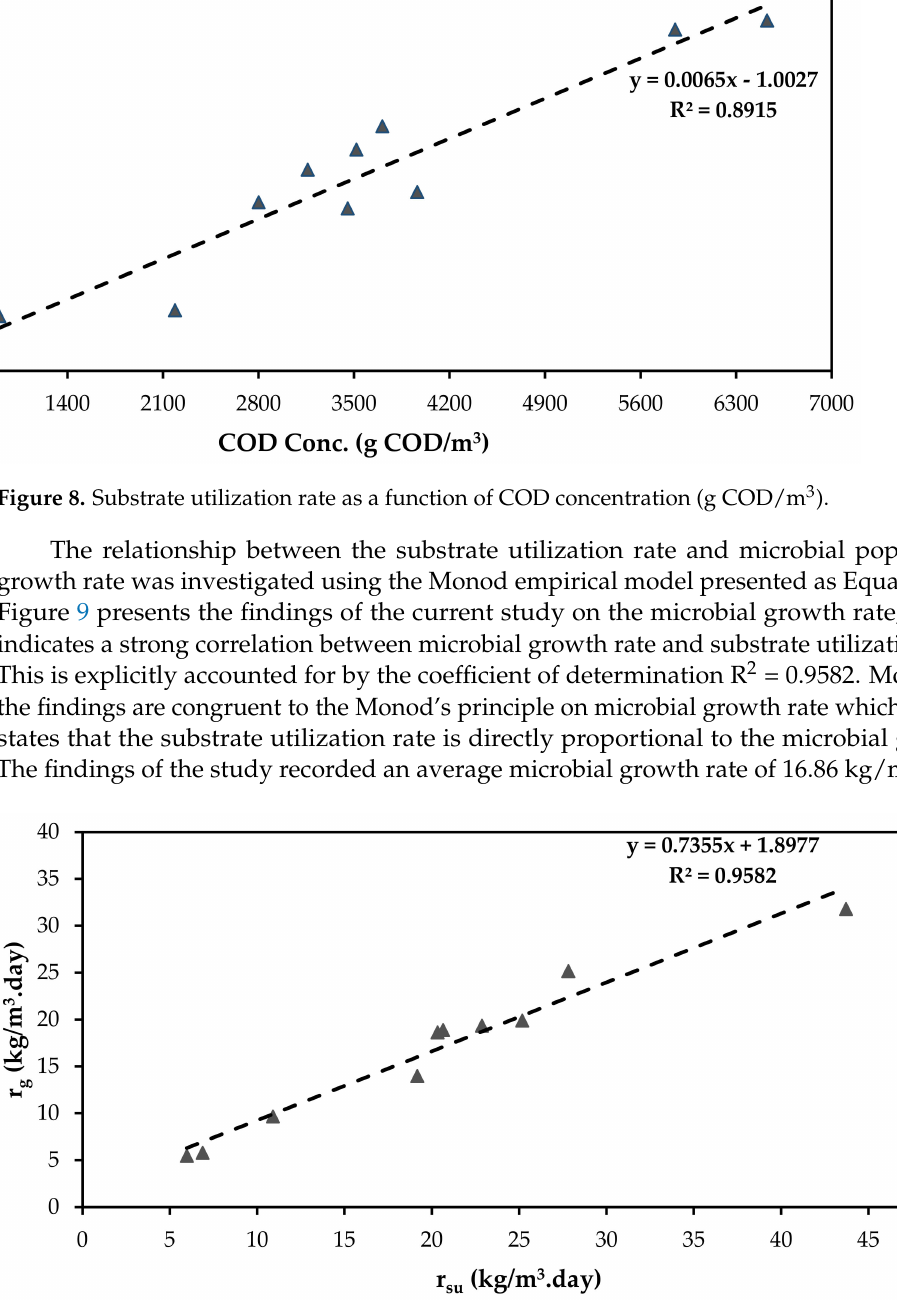
Figure 9. Microbial population growth rate as a function of substrate utilization